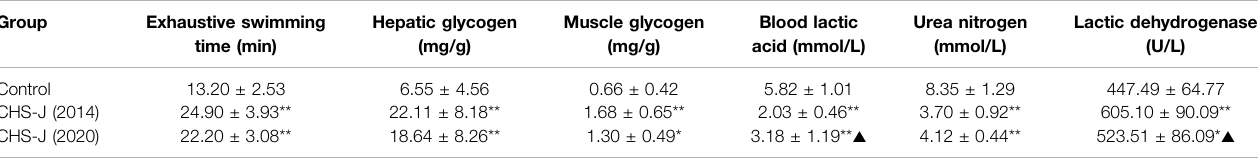
TABLE 2 | Effects of CHS-J samples produced in 2014 and 2020 on exhaustive swimming time, hepatic glycogen, muscle glycogen, blood lactic acid, urea nitrogen, and lactic dehydrogenase levels in mice ( n = 10, mean ± SD), * p < 0.05, ** p < 0.01 vs. control group, ▲ p < 0.05 vs. 2014.